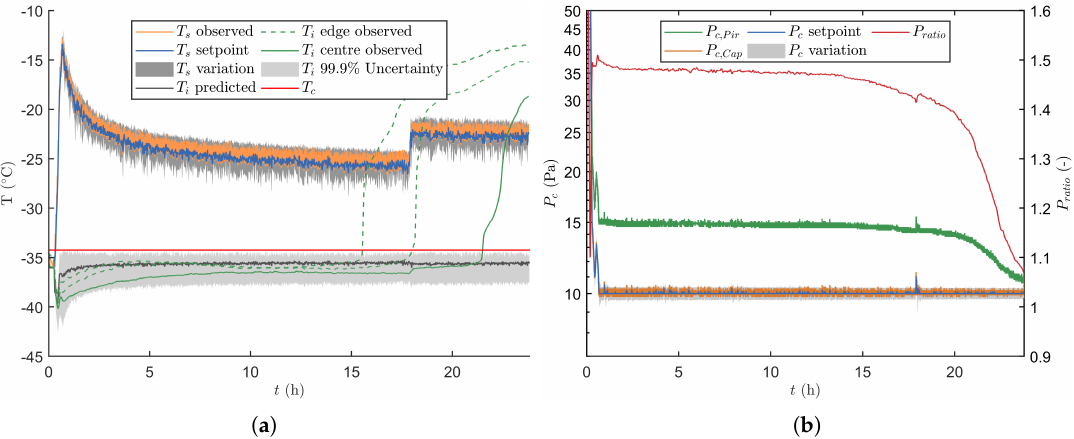
Figure 6. Second verification run without intended process disturbances. ( a ) Depiction of T s together with its associated variation, and T i . The latter variable was either estimated by the primary drying model, or experimental measured for both the edge and centre vials. ( b ) The different P c signals are plotted in time together with its regularly updated